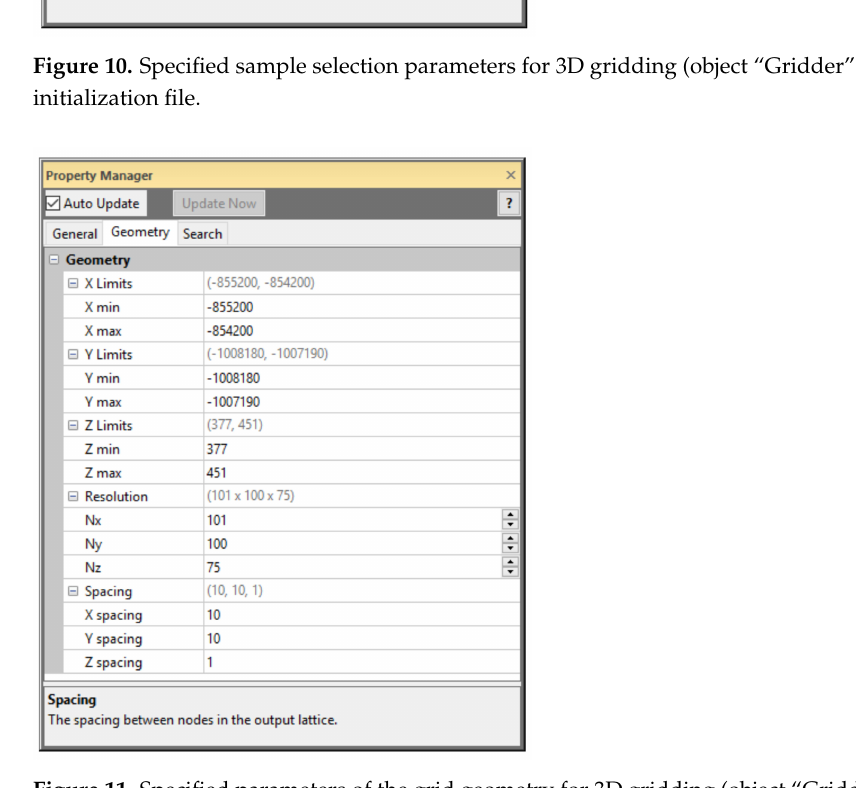
Figure 11. Specified parameters of the grid geometry for 3D gridding (object “Gridder”) taken from the initialization